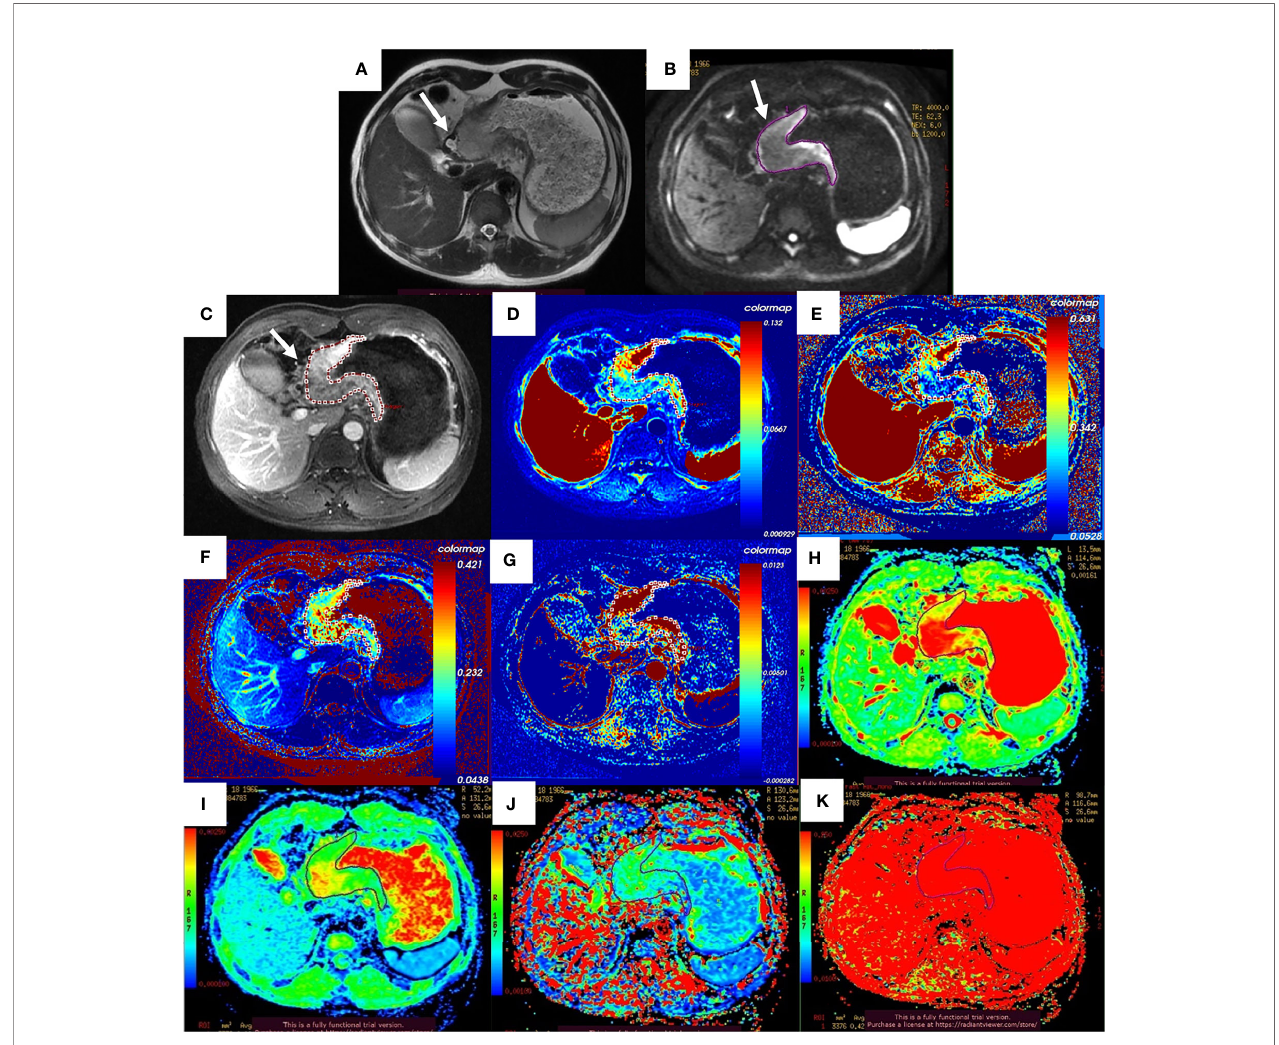
FIGURE 3 | Images ofa 52-year-old man with gastric adenocarcinoma in the bodyof thestomach who had non-response to NCT. In T2WI (A) , IVIM-DWI (B) , and contrast-enhanced imaging (C) , the gastricwallwas irregularly thickened with high signal intensity,diffusion restricted, andheterogeneously enhanced(white arrows). The pseudo-colorized K trans maps (D) , k ep map (E) , v e map (F) , v p map (G) , ADC standard map (H) , D map (I) , D* map (J) , and f map (K) show mixed red,green,and blue colorsin the correspondingtumor with a K trans of0.072 min − 1 , k ep of0.335 min − 1 , v e of 0.271, v p of 0.015, ADC standard of 2.140 × 10 − 3 mm 2 /s, D of 1.500 × 10 − 3 mm 2 /s, D*of 10.700 × 10 − 3 mm 2 /s, and f of42.2%.NCT, neoadjuvant chemotherapy; T2WI, T2-weighted imaging; IVIM-DWI, intravoxelincoherent motion diffusion-weighted